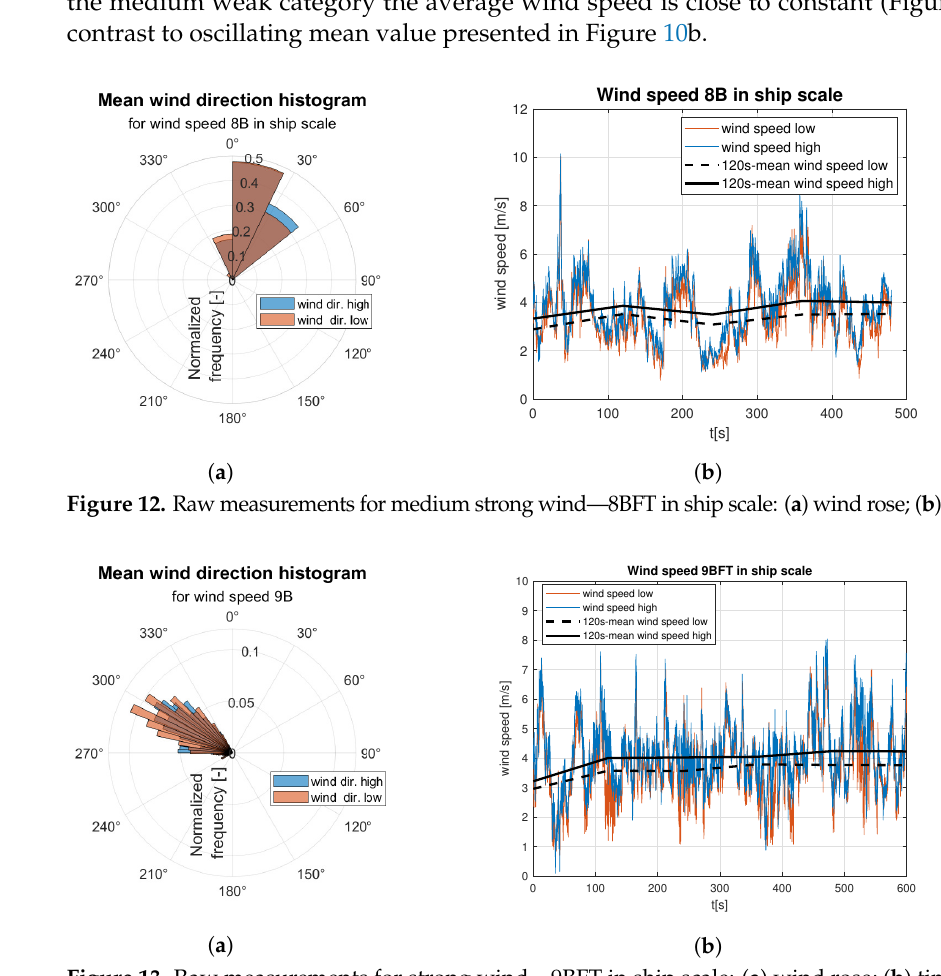
Figure 13. Raw measurements for strong wind—9BFT in ship scale: ( a ) wind rose; ( b ) time